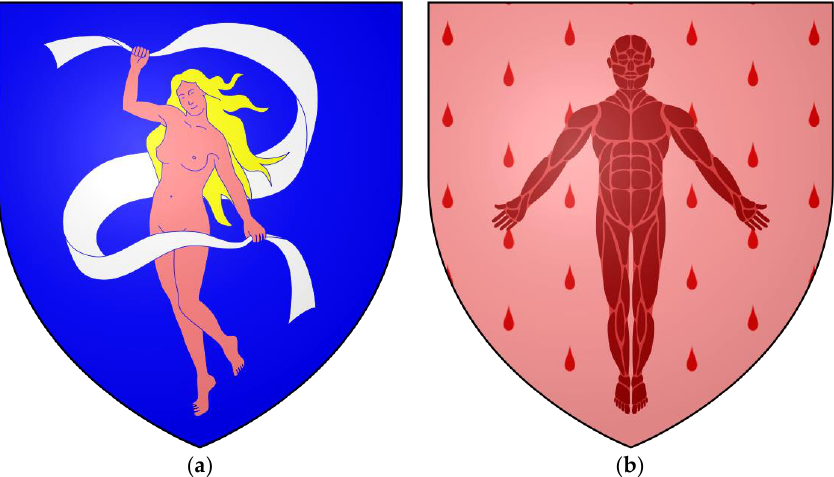
Figure 3. Examples of very detailed coats of arms: ( a ) The dancing maiden swirled in silk of House Piper (A Wiki of Ice and Fre: House Piper.svg 2018); ( b ) The flayed man on a field of blood drops belonging to House Bolton (A Wiki of Ice and Fire: House Bolton.svg 2018).